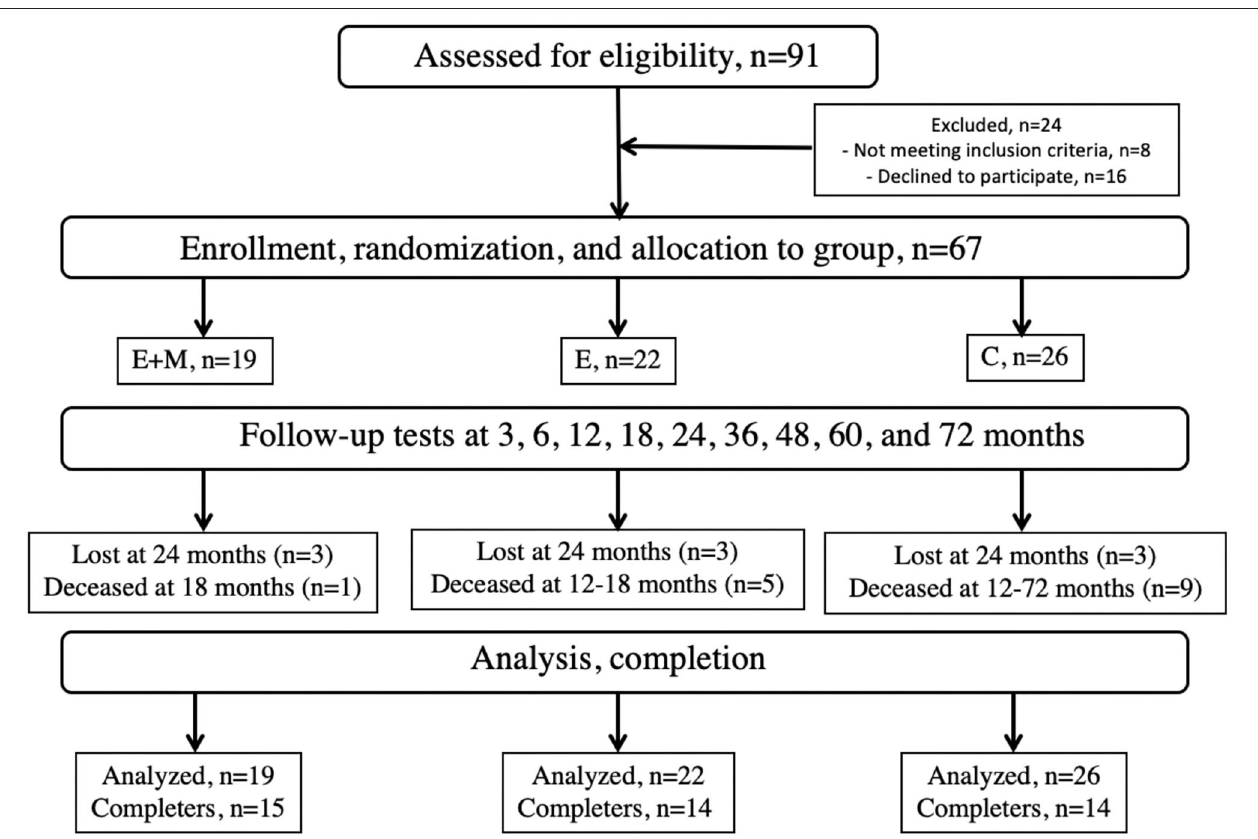
FIGURE 1 | Consort diagram. E, Exergaming agility exercise program for 3 weeks, E + M, Exergaming agility exercise program for 3 weeks followed by a three times weekly Exergaming exercise Maintenance program for 6 years, and C, Control, no exercise and no maintenance.